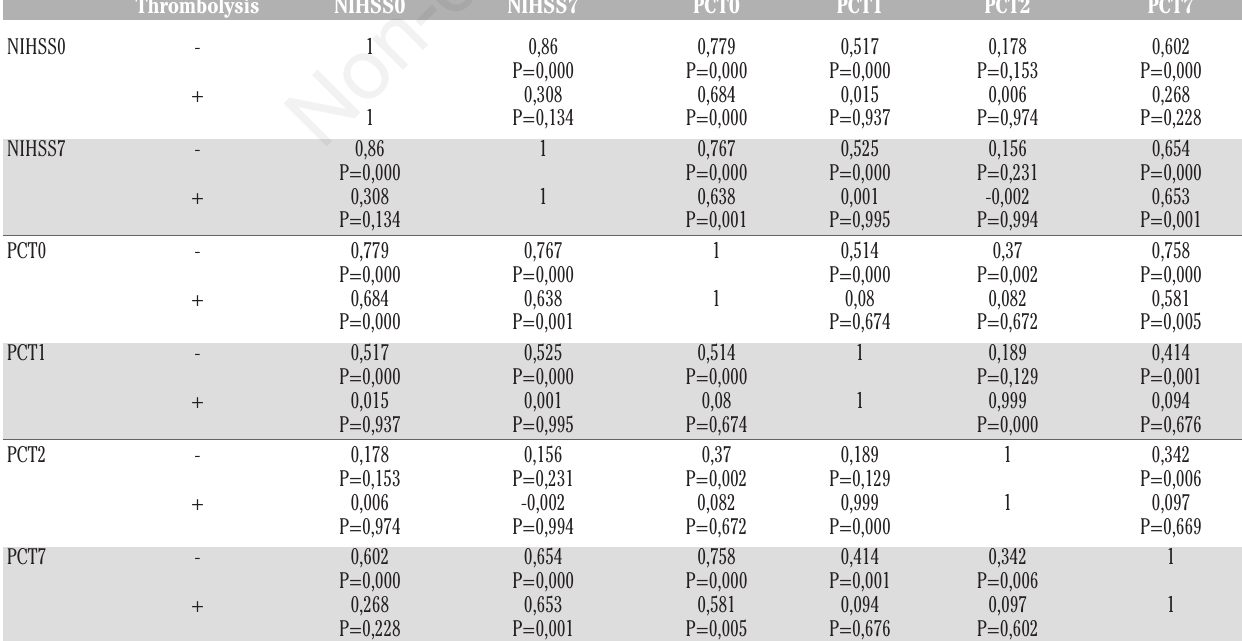
Table 2. Associations of NIHSS score at admission and at day seven and PCT values at admission, 24 hours, 48 hours and seven days after admission in both groups of patients.